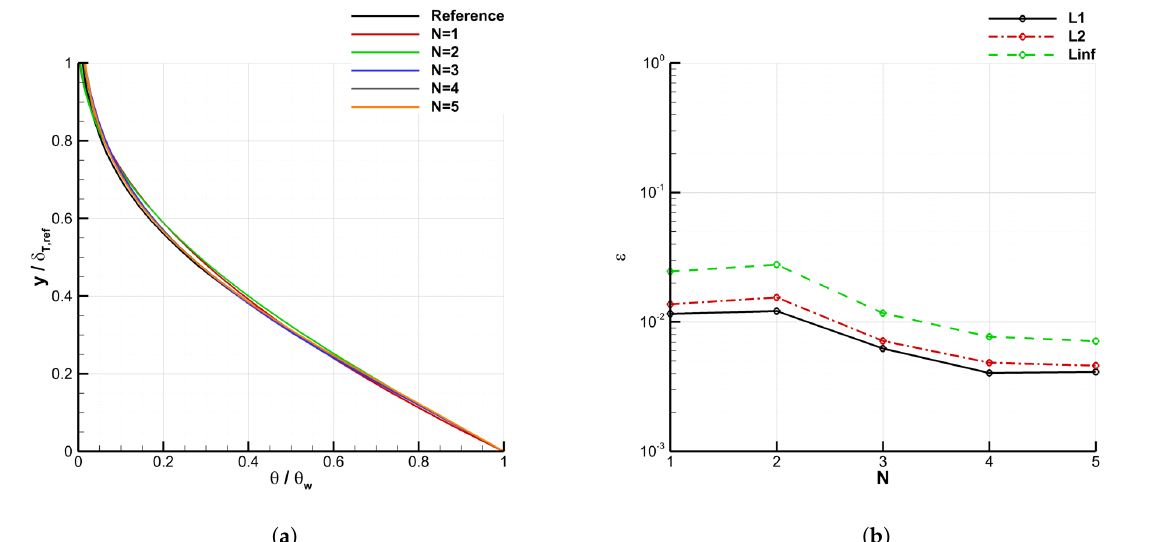
Figure 9. Temperature for N = 1 to N = 5, and for the reference CLICET solution. ( a ) temperature profiles at x / L = 1, ( b ) error. Test case 1, N x =